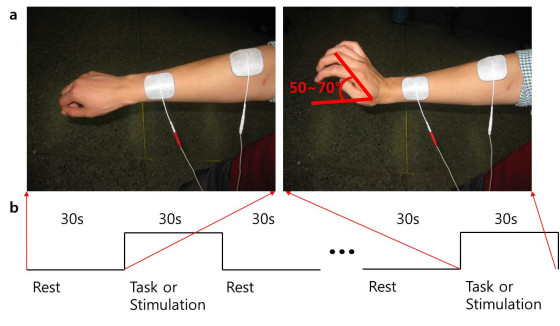
 Experimental design.